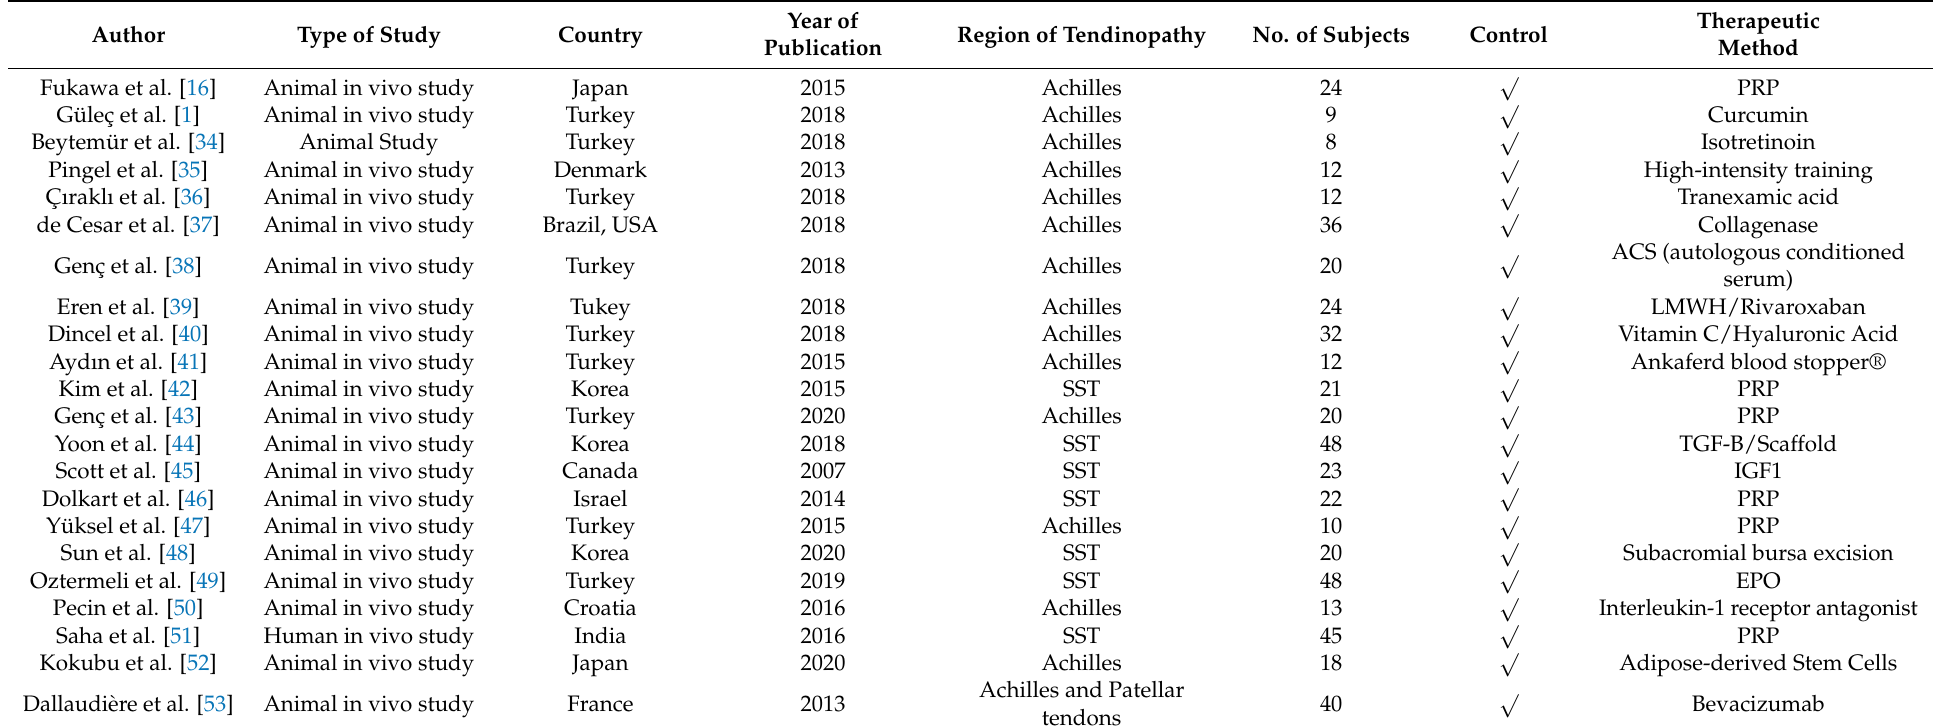
Table 1. Demographic data of collected studies with various therapeutic